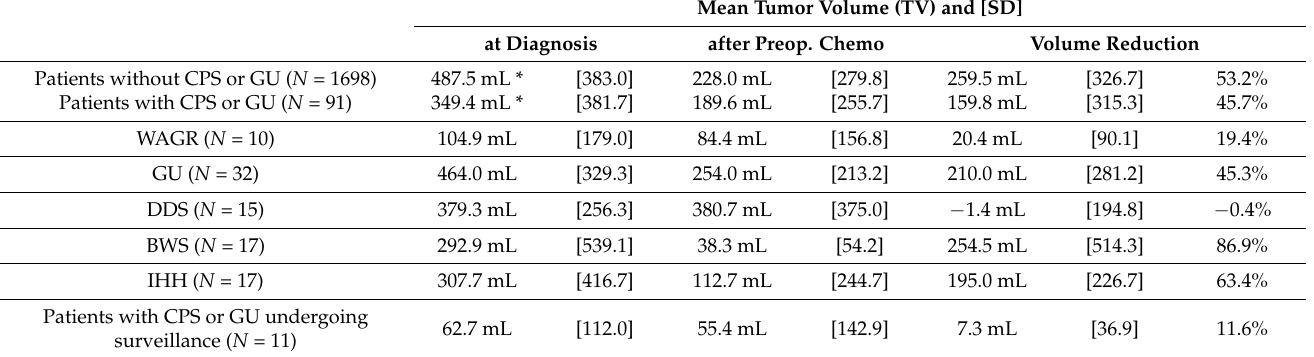
Table 4. Tumor volume (TV) at diagnosis and volume reduction achieved by preoperative (preop.) chemotherapy, * t -test: p < 0.001 for lower initial TV in patients with CPS. TV is not available for all patients. Standard deviation (SD); CPS: cancer predisposition syndrome; GU: Genitourinary malformations; BWS: Beckwith-Wiedemann spectrum; IHH: isolated hemihypertrophy; DDS: Denys-Drash syndrome; WAGR: Wilms tumor, aniridia, genitourinary abnormalities, range of developmental delays.